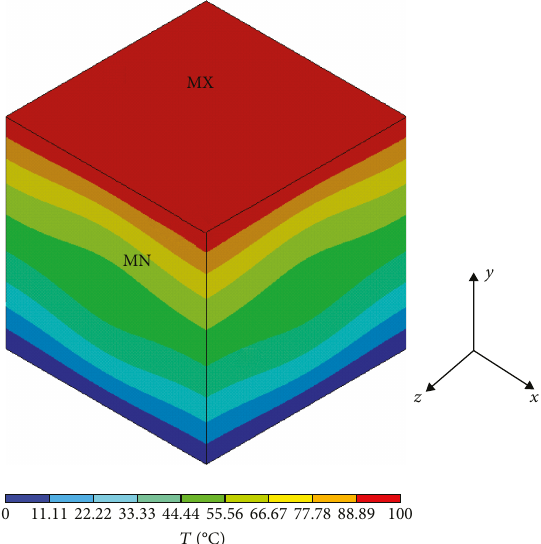
Figure 26: Temperature distribution of the microsphere carbonization model.